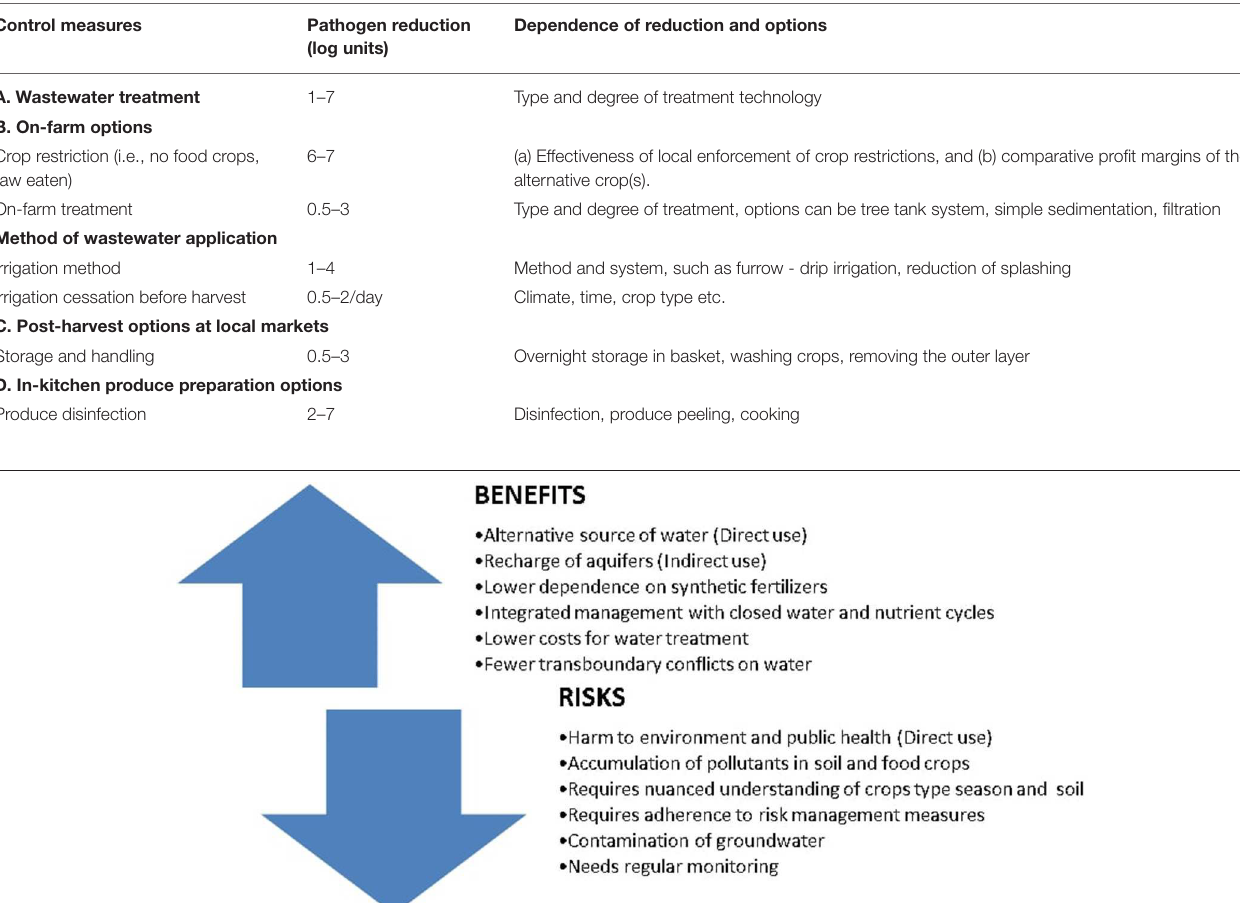
TABLE 1 | Pathogen reduction along Multi Barrier Approach, modified from Mara et al. (2010).